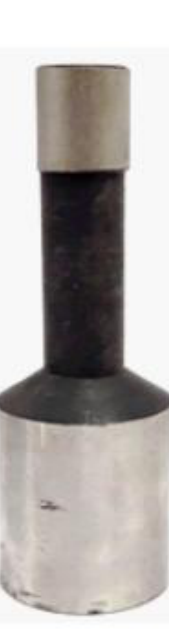
Figure 2. The 90CrSi alloy steel